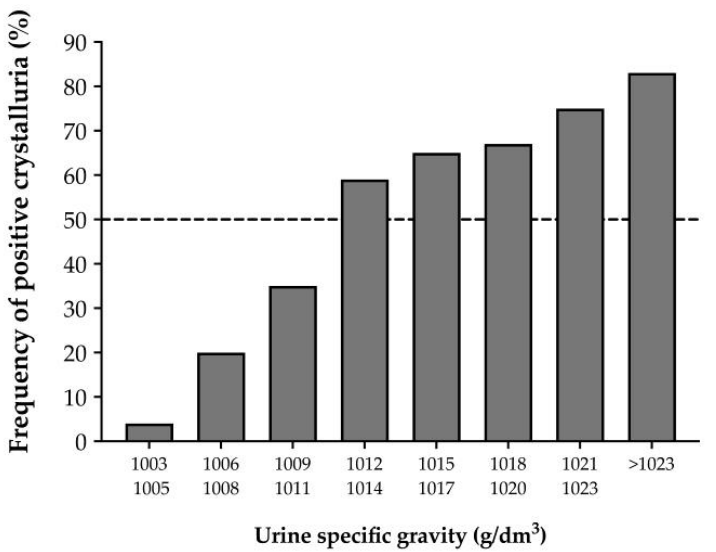
Figure 3. Relationship between urine-specific gravity and frequency of positive crystalluria (based on